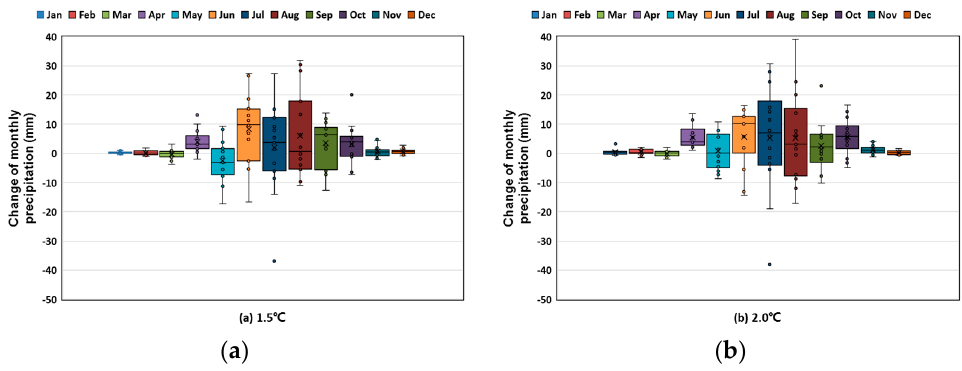
Figure 8. Change of monthly precipitation refer to baseline period ( a ) 1.5 °C; ( b ) 2.0 °C.